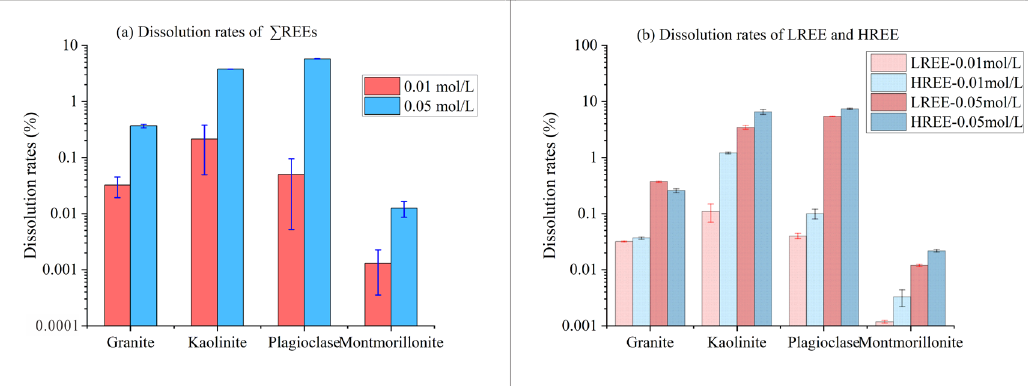
Figure 5. REE dissolution rates of samples in oxalic acid leachates of different concentrations: ( a ) Dissolution rates of ∑REEs ; ( b ) Dissolution rates of LREE and HREE. The blue error bar in ( a ) is the standard deviation of the ∑REE; the red and black error bars in ( b ) are the standard deviations of the LREE and HREE.